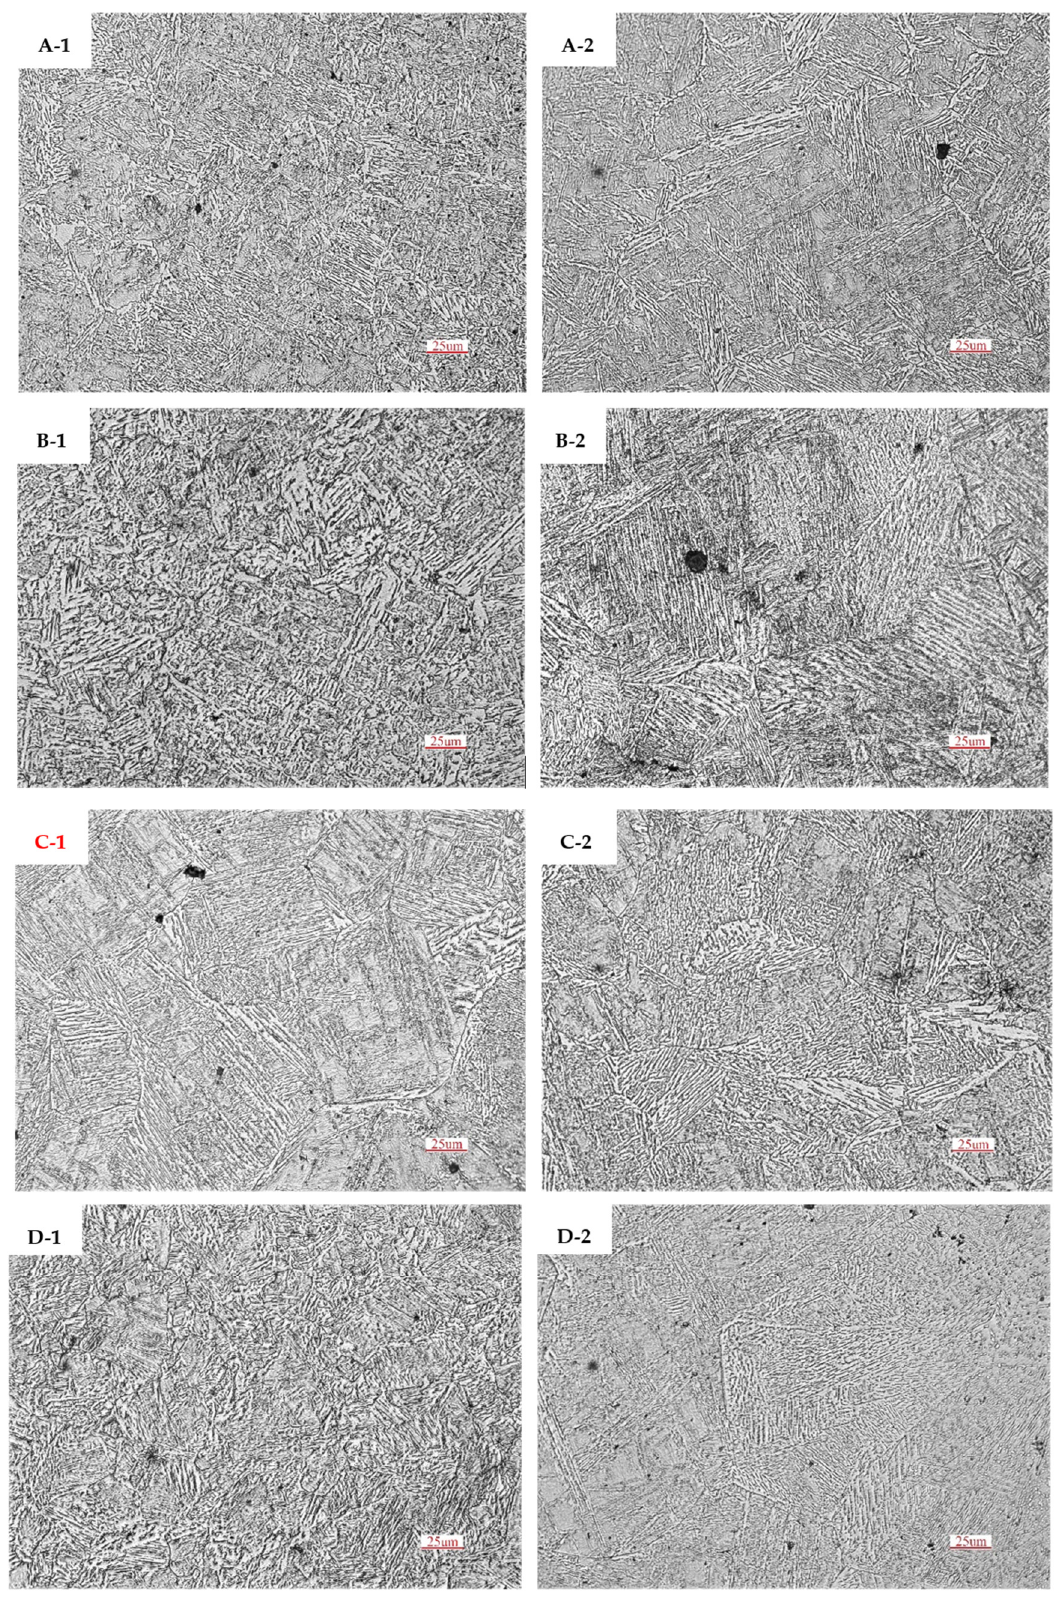
Figure 6. Microstructure near the fracture surface of four samples at 1373 K and 1473 K. Microstructure near fracture surface ( A – D ) of sample at 1100 ° C for ( A ‐ 1 – D ‐ 1 ). Microstructure near fracture surface ( A – D ) of sample at 1200 ° C for ( A ‐ 2 – D ‐ 2 ).